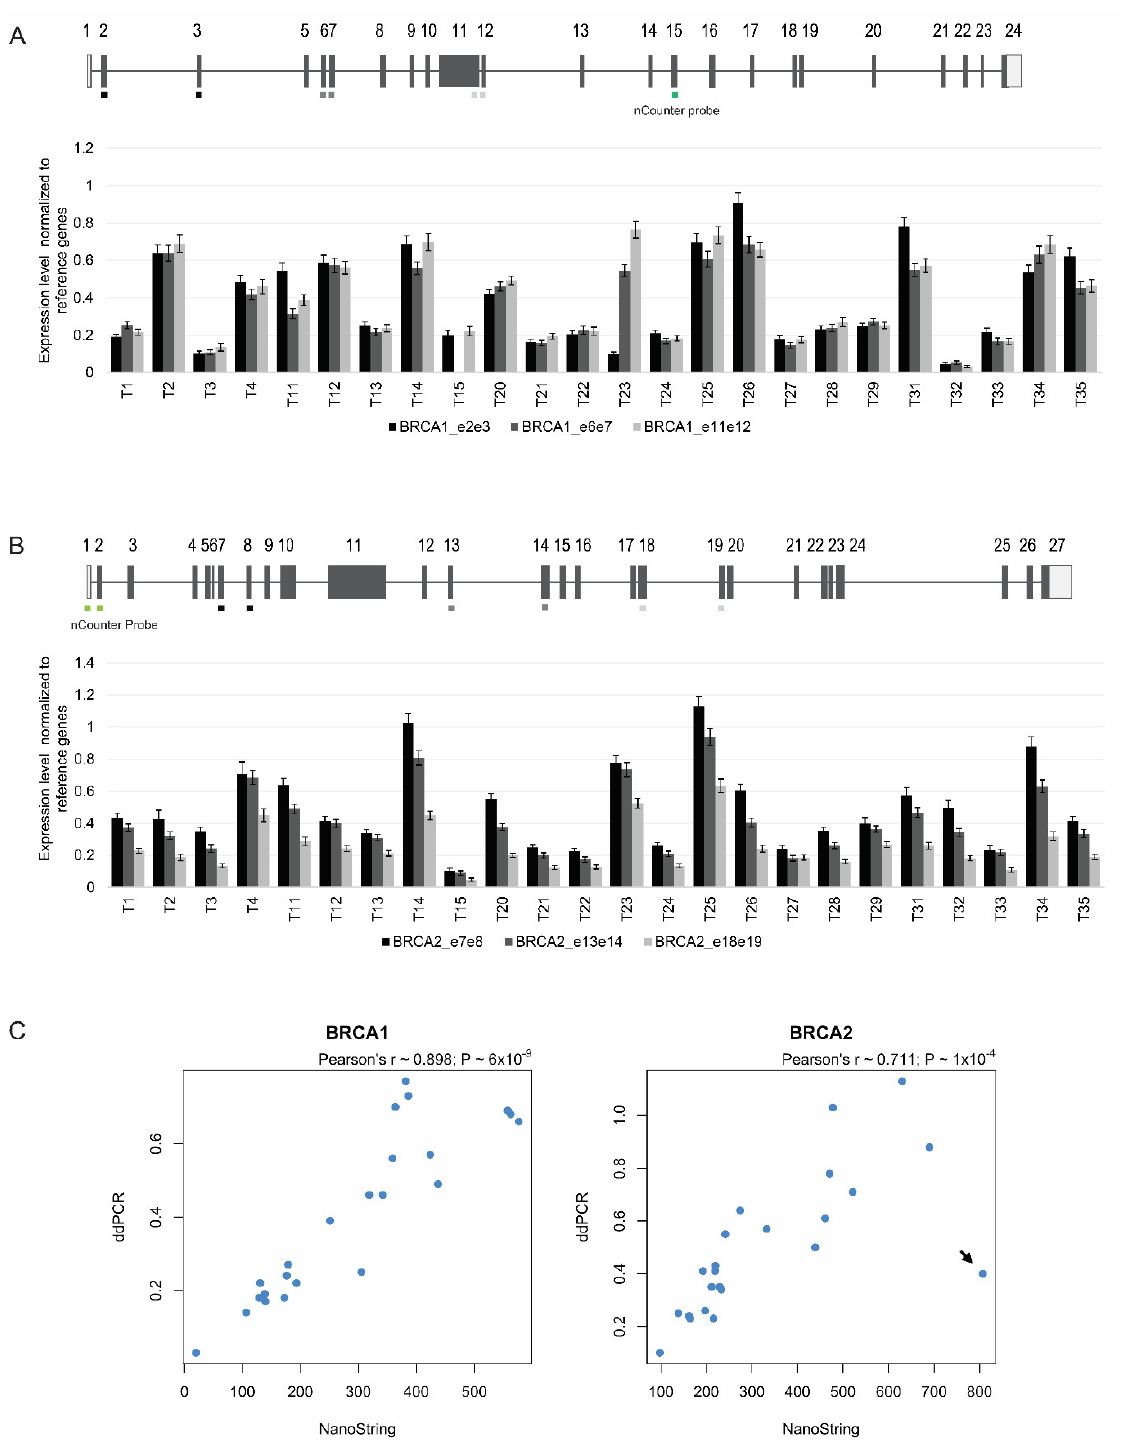
Figure 5. ddPCR quantitation of BRCA1 and BRCA2 expression in 24 ovarian cancers. ( A , B ) The normalized ratio of BRCA1 ( A ) and BRCA2 ( B ) mRNA to the three reference genes is plotted. Error bars represent 95% confidence intervals of the measurements. The different regions targeted by the ddPCR assays are indicated (exons 2/3, 6/7, and 11/12 of BRCA1 ; exons 7/8, 13/14, and 18/19 of BRCA2 ). The region targeted by the nCounter assay in each gene is denoted in green. ( C ) A strong correlation was observed between BRCA1 and BRCA2 expression values estimated with the NanoString nCounter and ddPCR assays. Arrow denotes tumor sample with discordant values, with a high BRCA2 mRNA value estimated by the NanoString nCounter system but a low value quantified by